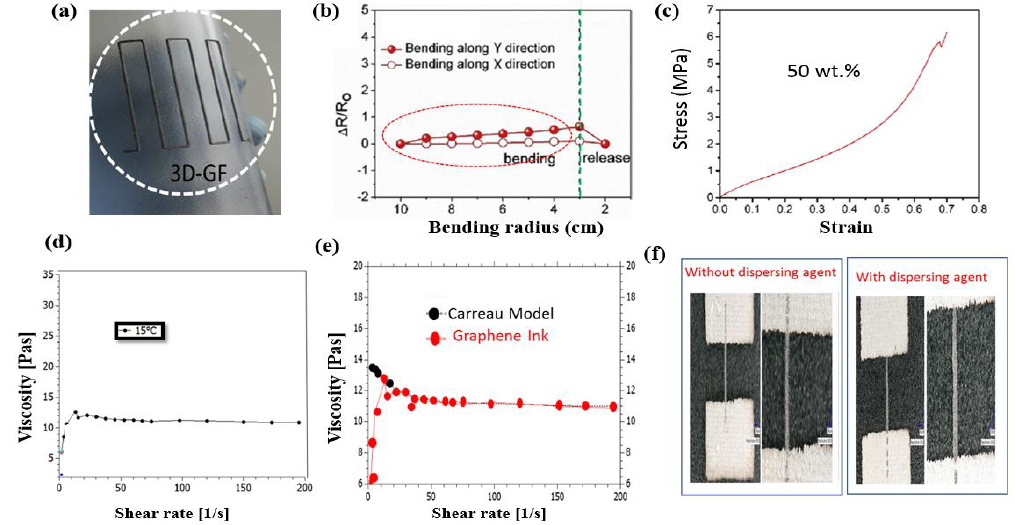
Figure 7. ( a ) Macrograph of 3D printed individual graphene filament, ( b ) electrical resistance of flexible circuit with 50 wt.% graphene content at various bending radius, and ( c ) typical stress strain curves of printed structure of 50 wt.% graphene loading, reproduced with permission from [88], published by Elsevier, 2018; ( d ) viscosity curves of graphene based ink with dispersing agent at 15 ◦ C temperatures, ( e ) graphene ink with dispersing agent viscosity curves with fitted Carreau Model curve, and ( f ) graphene printed paths produced with or without dispersing agent graphene ink were printed via piezoelectric inkjet printer at following parameters, nozzle diameter (50 m), 40 – 50 V, pulse length (150 – 200 s), reproduced with permission from [89], published by MDPI, 2018.